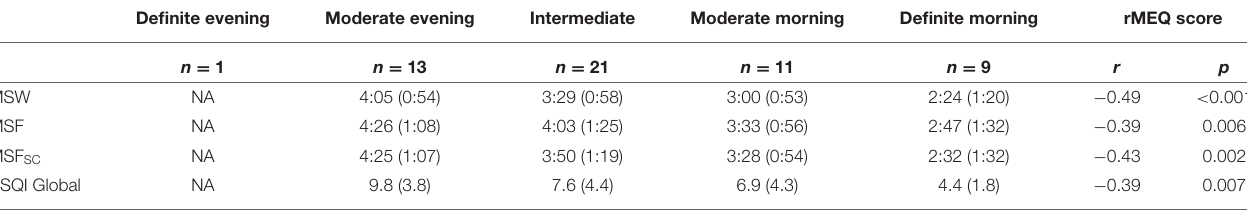
TABLE 2 | Descriptive statistics according to chronotype and Pearson correlations between rMEQ score and sleep mid-point (MCTQ) and sleep quality (PSQI) scores. Definite evening Moderate evening Intermediate Moderate